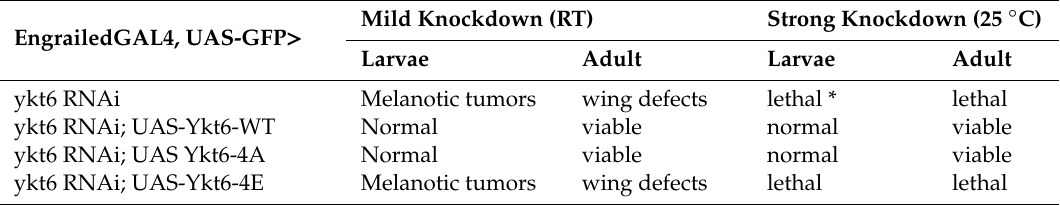
Table 2. Depletion of Ykt6 by RNAi (engrailed-Gal4, UAS-GFP / UAS-ykt6 RNAi; larvae reared for three days at RT or 25 ◦